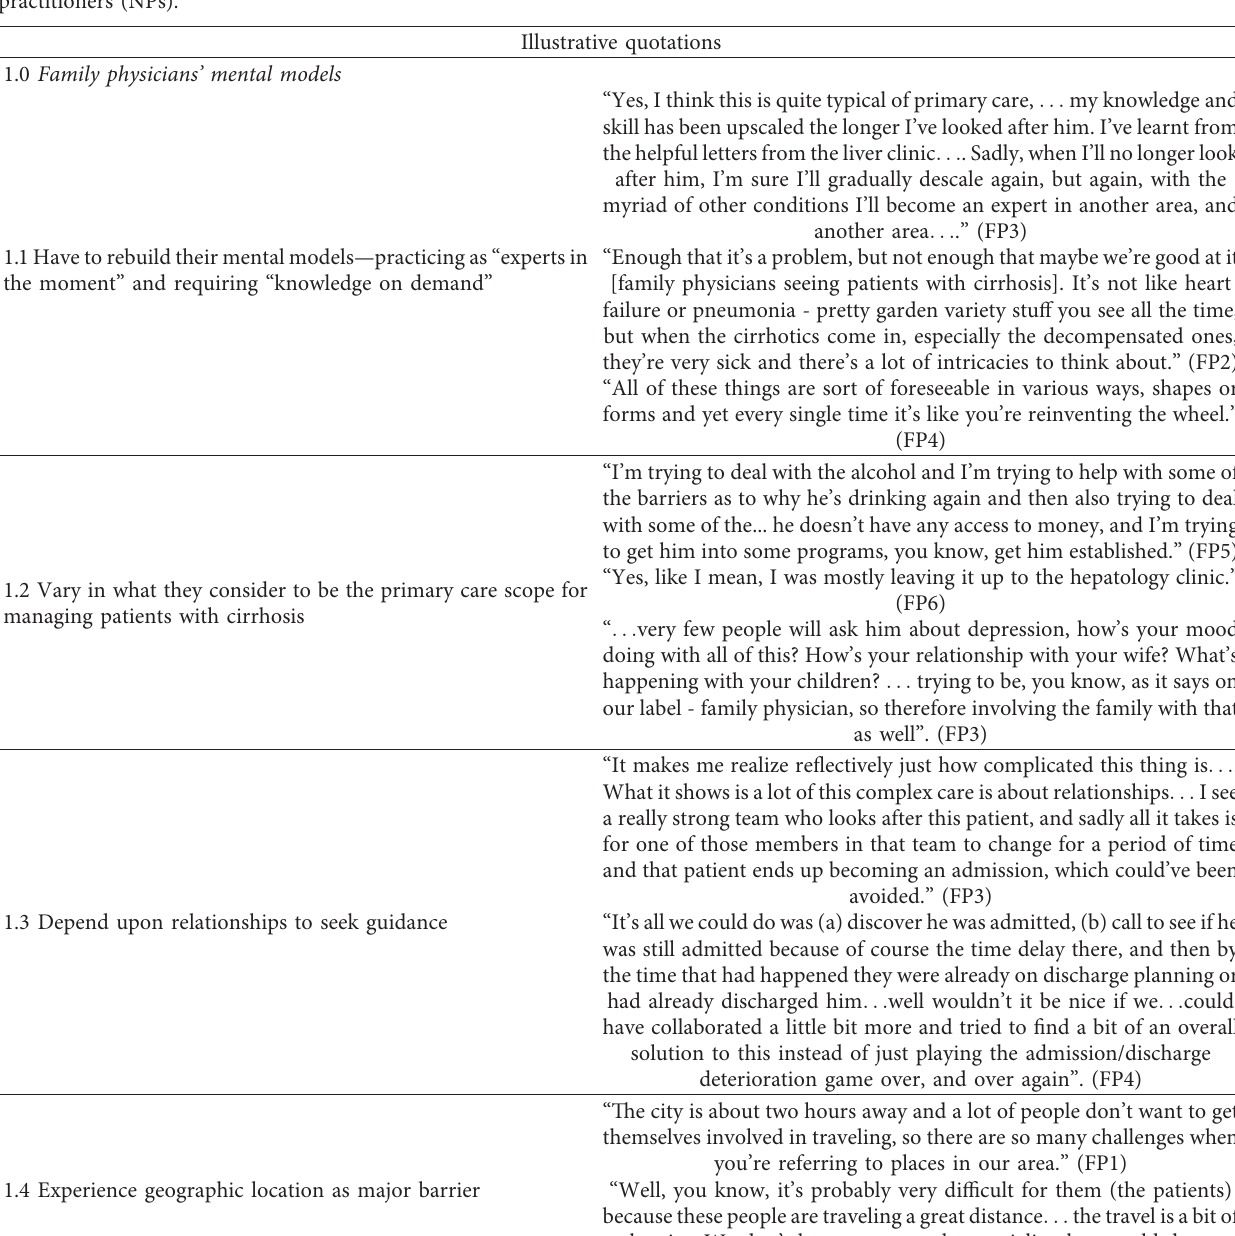
Table 3: Illustrative quotations from data generated by CTA interviews with family physicians (FPs), specialists (SPs), and nurse practitioners